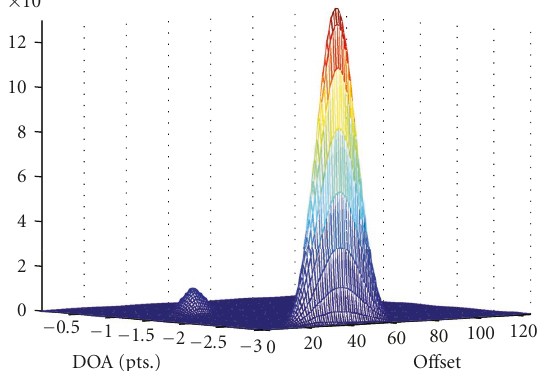
Figure 13: Amplitude of MW-MUSIC functional as a function of DOA and o ff set.